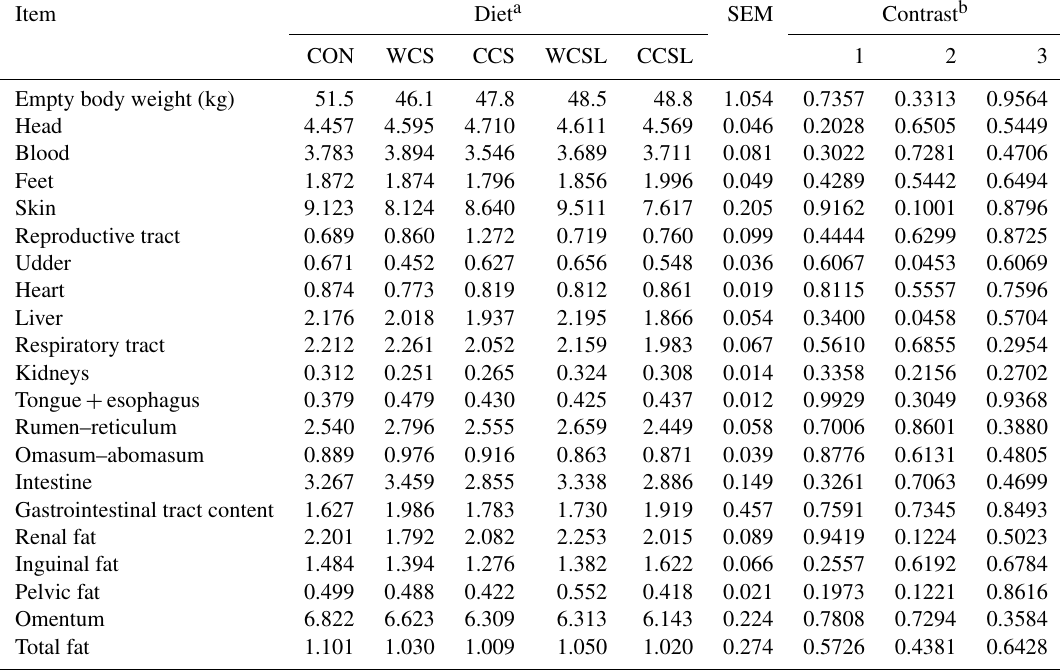
Table 5. Non-carcass components (% of the empty body weight) of Santa Inês cull ewes fed high-concentrate diets with cottonseed associated with calcium